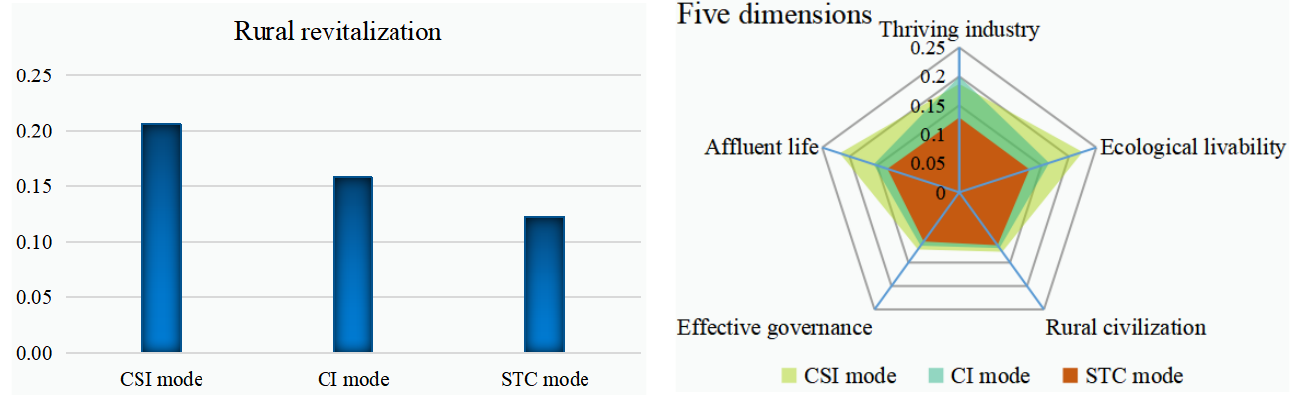
Figure 4. Comparing the promoting effects of different WRCLC modes on rural revitalization and its five dimensions. Note: The data in Figure 4 are the average values from Table 3.